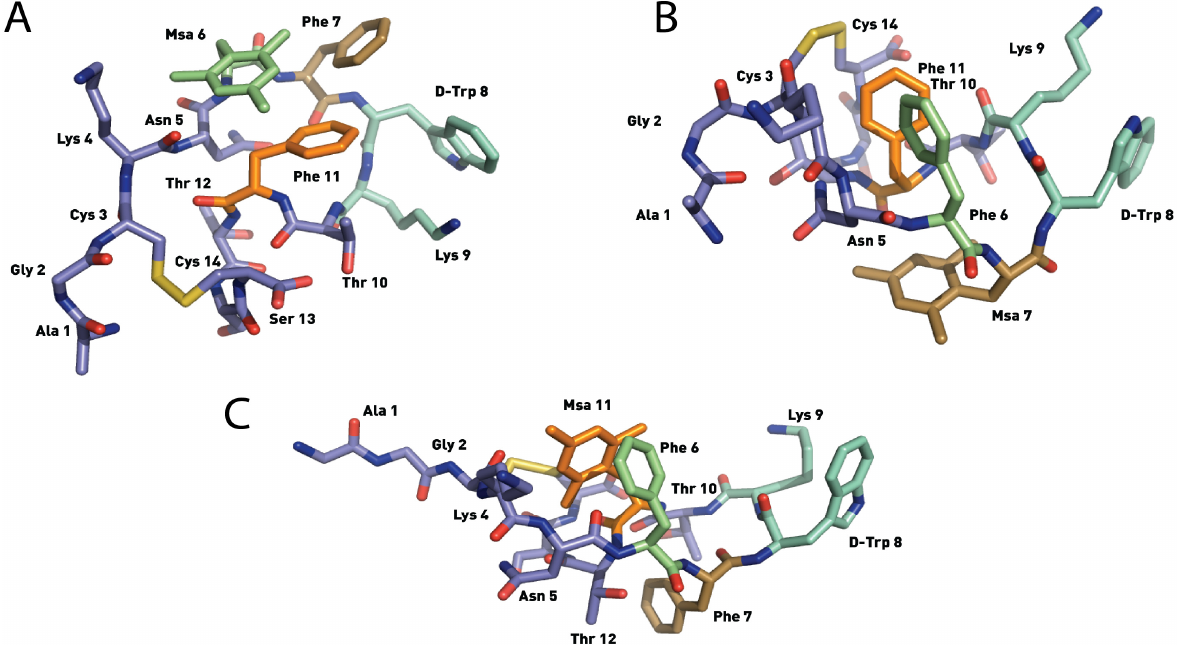
Figure 6. Structures of the lowest energy conformers of [ L -Msa6, D -Trp8]-SRIF ( 4 ) ( A ), [ L -Msa7, D -Trp8]-SRIF ( 5 ) ( B ) and [ L -Msa11, D -Trp8]-SRIF ( 6 ). ( C ). Hydrogen atoms have been omitted for